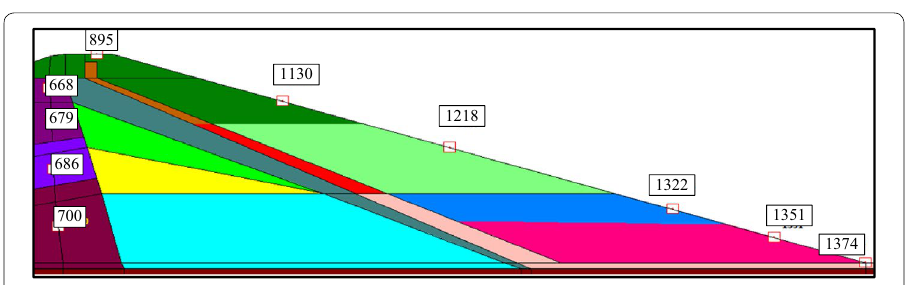
Fig. 5 Material properties with node histories